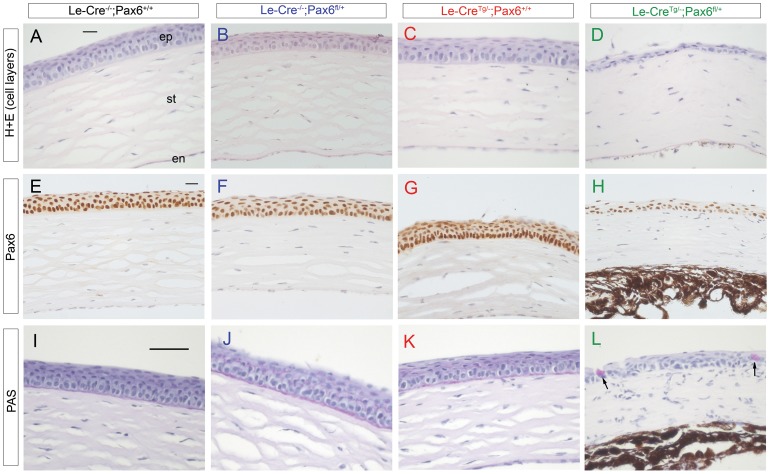
Histology and immunohistochemistry of adult corneas of four genotypes from Le-CreTg/−; Pax6+/+ × Le-Cre−/−; Pax6fl/+ crosses in stage 1.(A–D) H & E stained corneas showing normal morphology in controls (A–C) but reduced numbers of corneal epithelial layers in the Le-CreTg/−; Pax6fl/+ cornea shown in (D). (E–H) Pax6 immunostaining (brown endpoint) in the corneal epithelium of all four genotypes. (I–L) Periodic acid-Schiff (PAS) staining (purple-magenta endpoint) in cornea showed goblet cells were absent from the corneal epithelium of the three control genotypes (I–K) and some experimental Le-CreTg/−; Pax6fl/+ eyes (not shown) but present in other Le-CreTg/−; Pax6fl/+ eyes (arrows in L). Scale bars: A–H = 20 µm, I–L = 50 µm. Abbreviations: en, corneal endothelium; ep, corneal epithelium; st, corneal stroma.